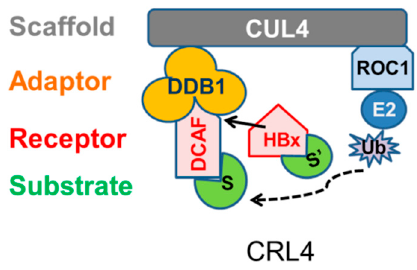
Figure 1. Cullin-4 RING ubiquitin ligase complex (CRL4): The CRL4 complex has a modular structure consisting of the cullin-4A (CUL4) scaffold, the damaged DNA binding protein 1 (DDB1) adaptor protein, and the DCAF receptor (DCAF) proteins that recruit substrate (S) proteins for ubiquitination and degradation. The crooked S’ indicates different substrates recruited by HBx. The regulator of cullins protein 1 (ROC1) contains a Really Interesting New Gene (RING) finger domain, which binds the ubiquitin-charged E2 (ubiquitin conjugating enzyme) [36]. The hepatitis B virus (HBV) HBx protein is a viral DCAF that binds to DDB1 [24,25] via a motif shared with cellular receptors [26,30] (reviewed in Reference [34]). In the present study, the CRL4 complexes from uninfected and HBV-infected human hepatocytes were isolated and the associated proteins were identified and compared to provide insight into the impact of HBV replication on the CRL4 complex. Figure is modified with the publisher’s permission [37].